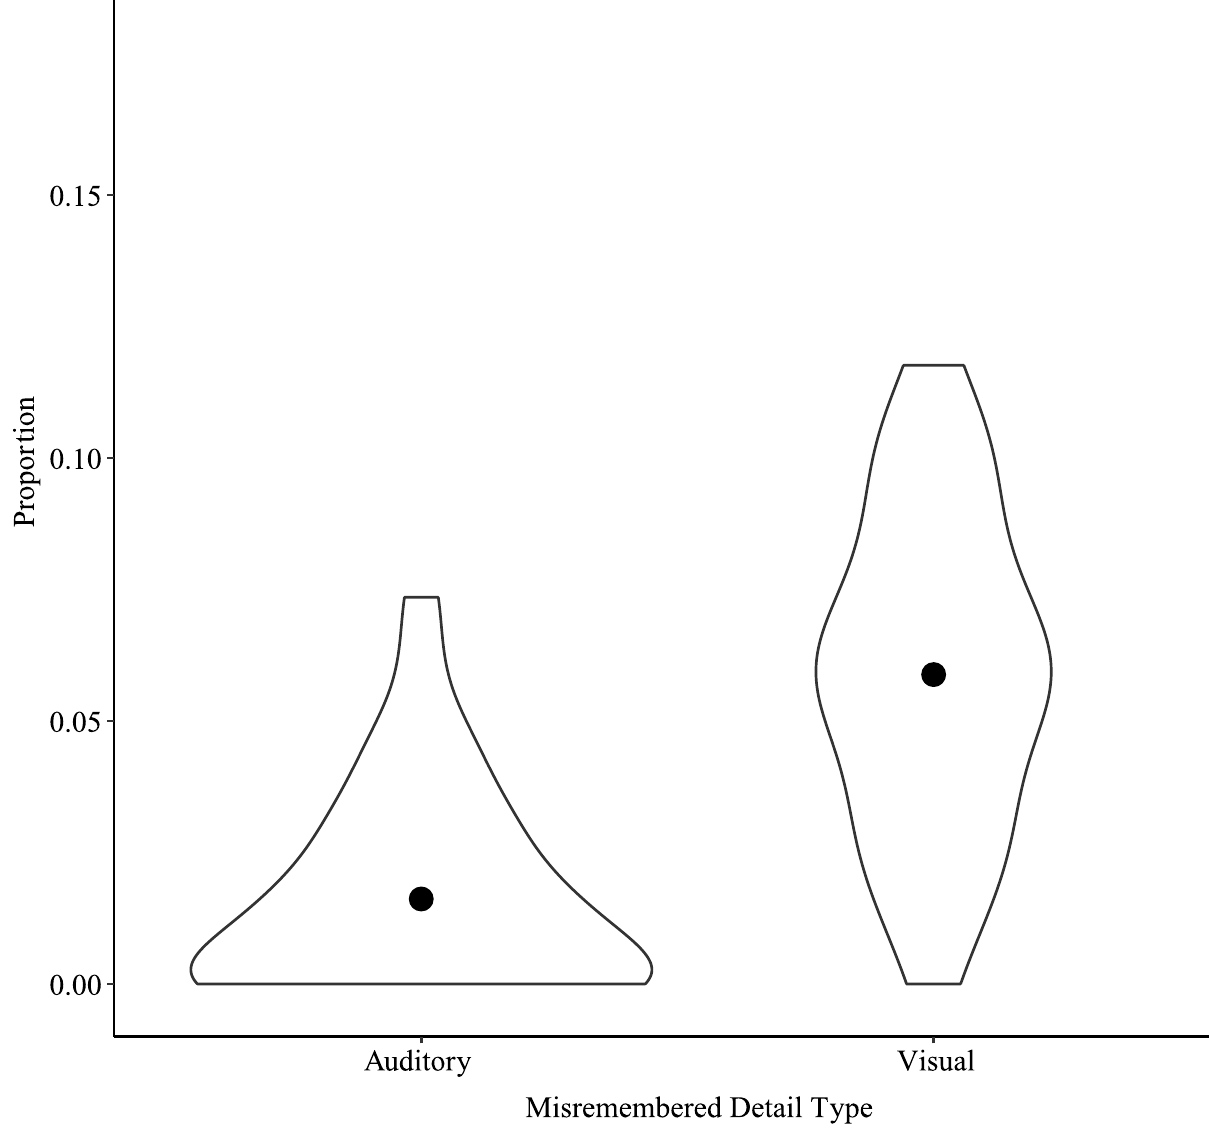
Fig 9. False recollections by Misremembered Detail Type for the Multimodal Narrative Condition in Study 2. Points show means for each Misremembered Detail Type in the Multimodal Narrative Condition. Note the y-axis scale, indicating very few false recollections.